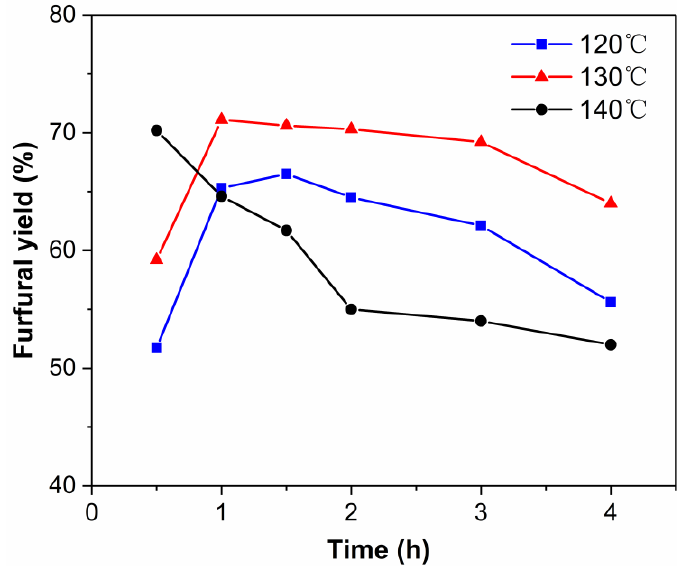
Figure 5. Effect of reaction temperature on the dehydration of xylose into furfural. Reaction conditions: 200 mg of xylose was dissolved in 1000 mg of EMIMBr; molar ratio of SnCl 4 :xylose = 1:10.